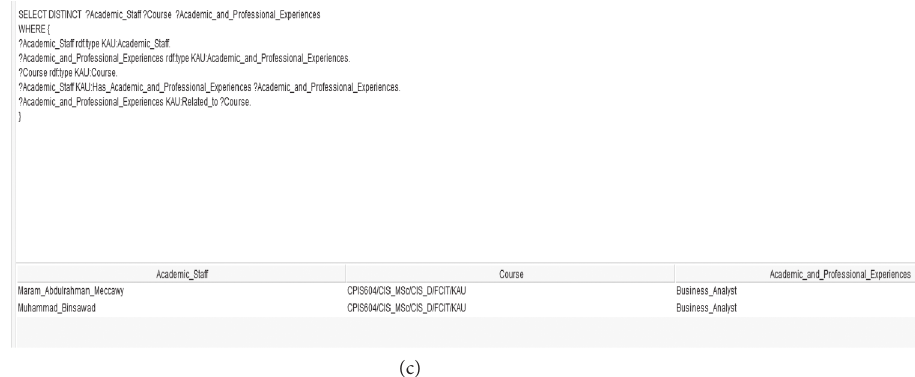
Figure 6: The visualization of Related_to property with academic and professional experiences and the results of the query.